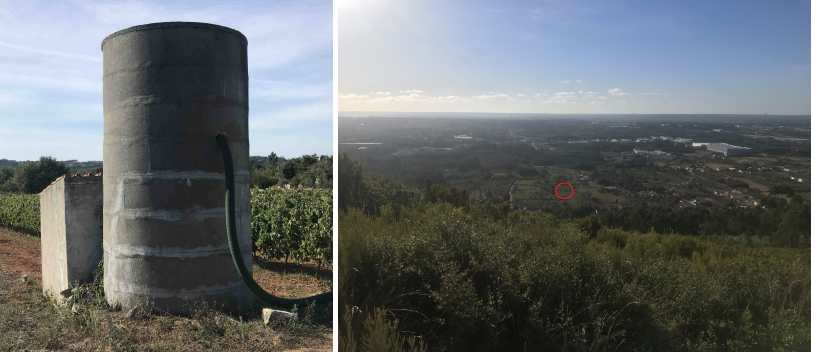
Figure 11. Structure used as target ( left ) and one of the photos used in the georeferencing procedure, with the target marked with a red circle ( right ).